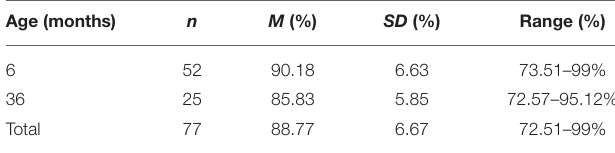
TABLE 1 | In lab ML agreement without participants A and